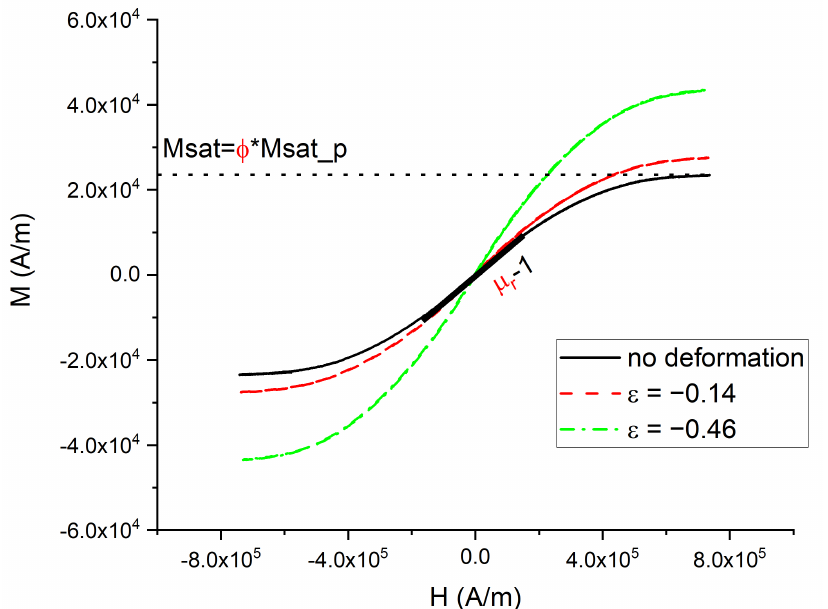
Figure 6. Magnetization versus applied field for different compression. Bold line and dotted lines highlight the magnetic permeability and saturation of the non-deformed composite,